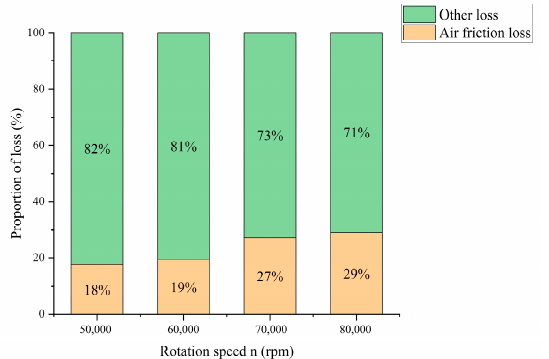
Figure 9. Comparison diagram between calculated wind friction loss and measured total loss by loss separation.